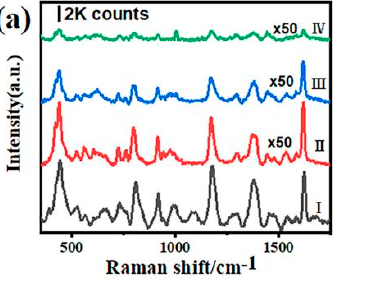
Figure 5. ( a ) Ordinary Raman spectra of CV ( Ⅰ :10 − 2 M aqueous solution) and SERS spectra of CV molecules with different concentrations on the same SERS substrate ( Ⅱ :10 − 11 M; Ⅲ :10 − 12 M; Ⅳ :10 − 13 M). Note: “ × 50” indicates that the signal is magnified by 50 times for seeing. SERS intensity as a function of the concentration of the CV molecules: ( b ) 442 cm − 1 ; ( c ) 1624 cm − 1 . Table 2. Calculated average enhancement factor with different characteristic Raman peaks.